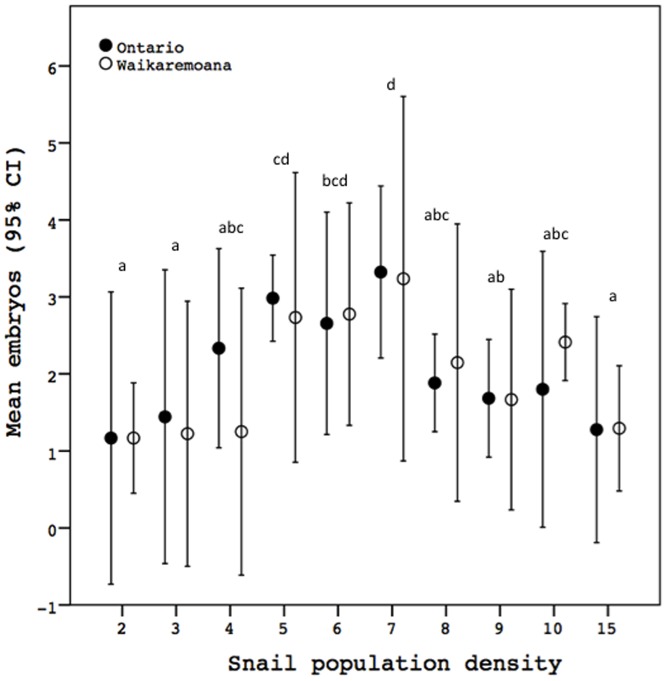
Mean embryo production per female across the ten population density treatments.Shared letters above error bars denote means (pooled across lineages; Tukey's honestly significant difference) that are not significantly different, while different letters indicate that p<0.05 for pairwise comparisons. p (a) = />0.189; p (b) = />0.101; p (c) = />0.086; p (d) = />0.817.